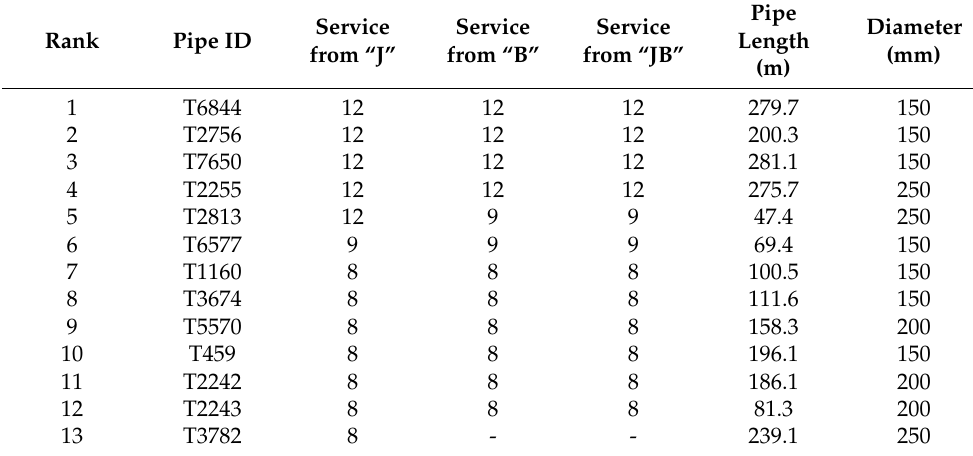
Table 8. List of pipes in the red risk group from each service scenario and ranking for rehabilitation based on the PC